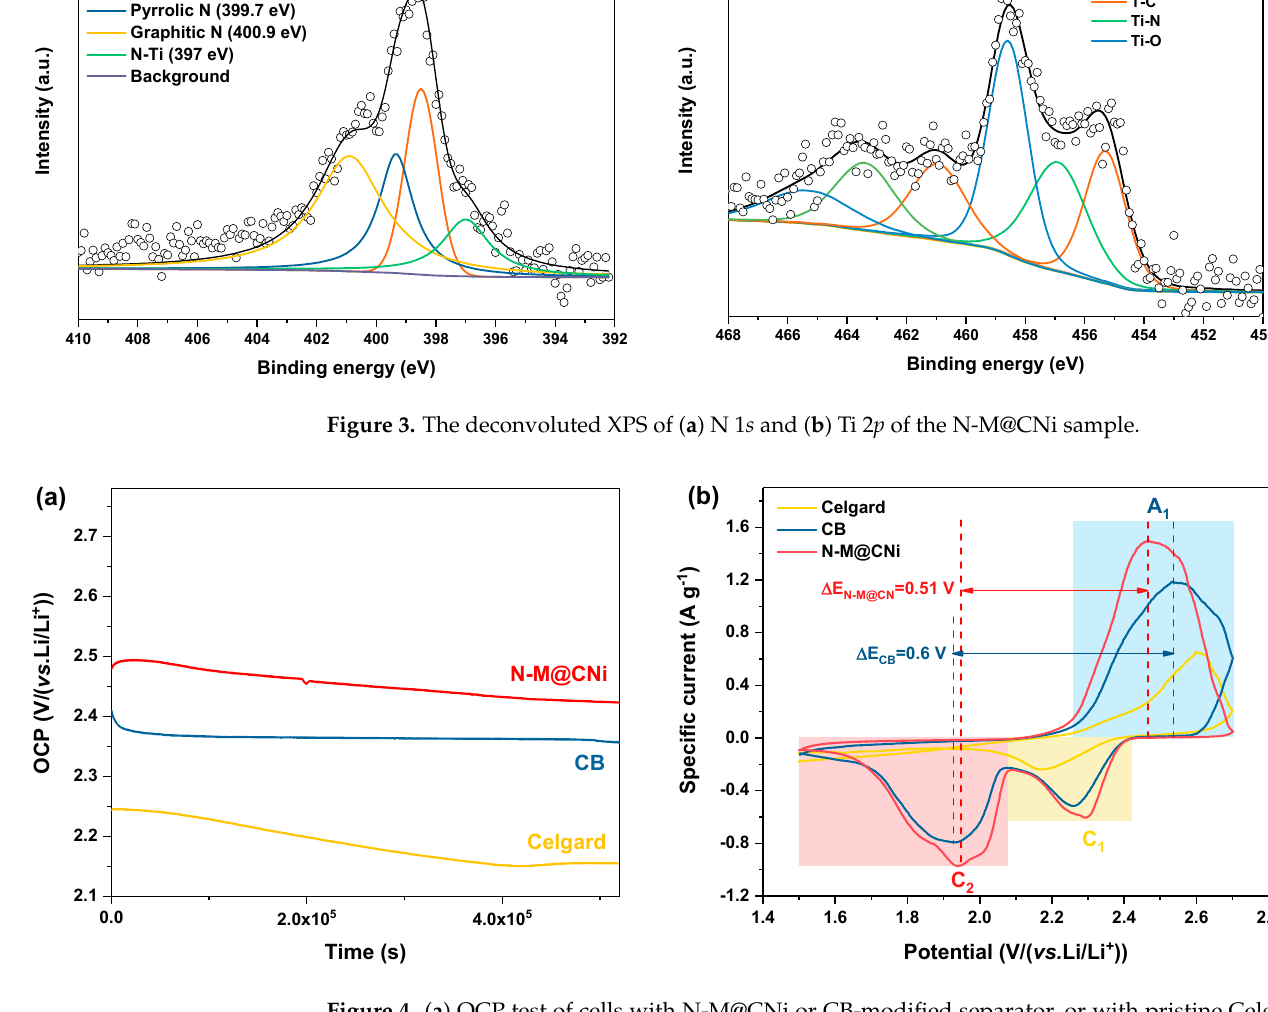
(OCP) test was conducted on cells with CB and N-M@CNi-modified separator, as well as